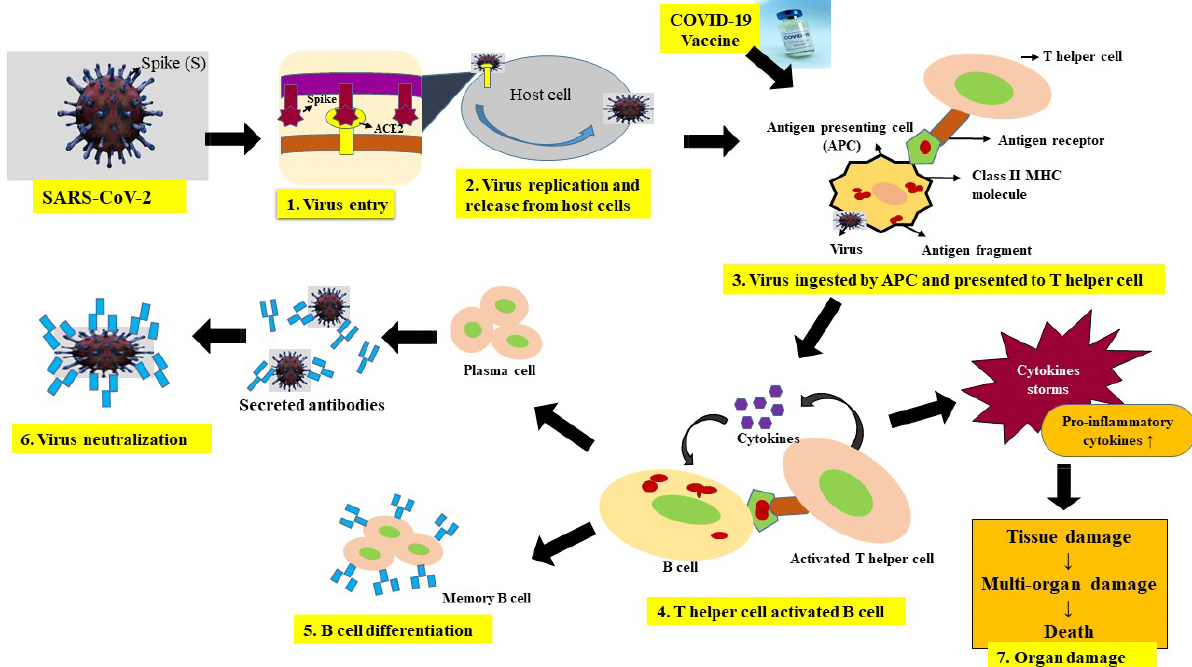
Figure 1. The picture depicts the overview of host immune response to COVID-19 infection or COVID-19 vaccine. SARS-CoV-2 enters the host cell through its S protein by receptor mediated endocytosis. Inside the host cell, virus replicates and new viral particles are released causing target cell lysis. Antigen presenting cells recognize the virus infected cells and phagocytize them. Process the viral antigen and present to the Th cells via class II MHC. In the case of vaccine, following the vaccine injection, antigen presenting cells, process the S protein (in case of viral vector vaccines and nucleic acid vaccines) or process the antigen from the inactivated whole virus vaccine, and present to the Th cells as above. Th cells recognize the viral antigen and activated and secrete cytokines which in turn activate B cells. Activated B cells differentiate into plasma cells and memory B cells. Plasma cells secrete antibodies which neutralize the viral antigen. As disease progress pathogenic CD4 + secrete higher amounts of proinflammatory cytokines such as IL-6, monocyte chemoattractant protein 1 (MCP-1), TNF-α, granulocyte-macrophage colony-stimulating factor (GM-CSF), etc., which in turn cause infiltration of neutrophils and tissue macrophages, lymphocytes leading to tissue and organ failure. Memory cells formed due to vaccine or infection, following the repeat encounter of the same antigen or virus gets activated and differentiated into antibody producing plasma cells. CD4: cell differentiation 4; ↓: decrease; ↑: